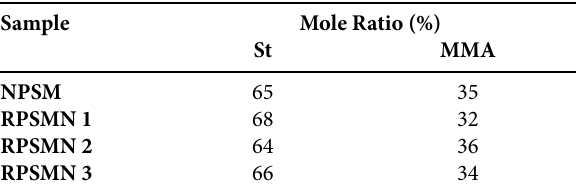
Table 3: Extracted data from 1 H NMR spectroscopy analysis of the pure poly (styrene-co-methyl methacrylate) and its nanocompos- ites